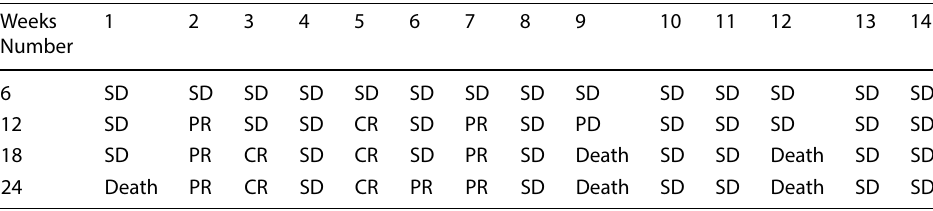
Table 5 Short-term efficacy evaluation of